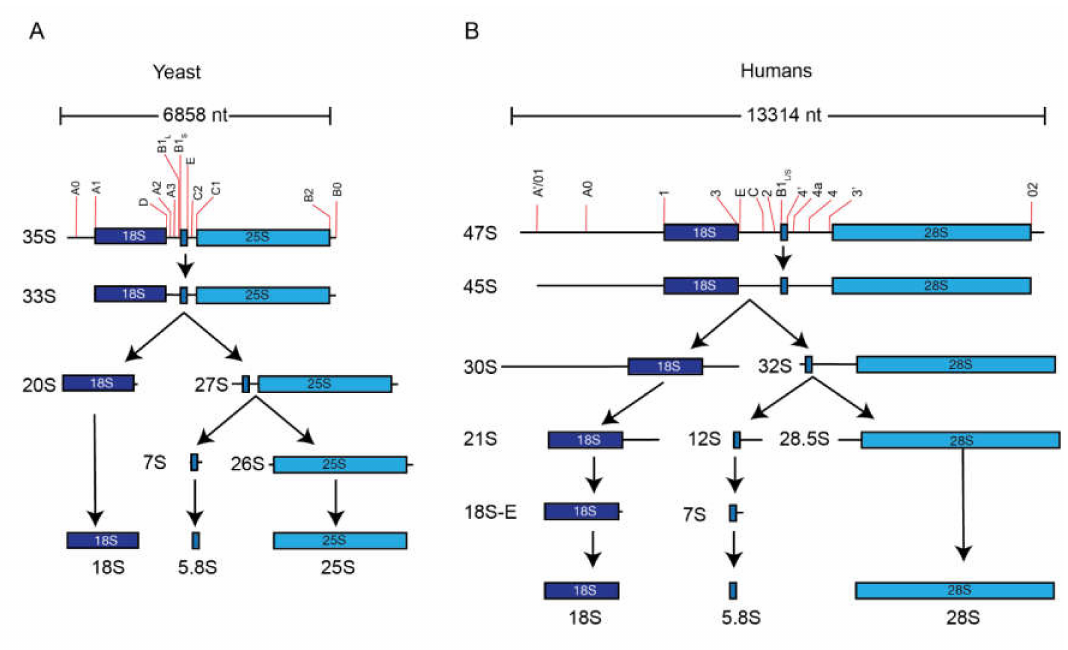
Figure 4. Simplified pathway of rRNA processing. ( A ) Yeast and ( B ) human rRNAs are generated from long polycistronic precursor molecules that must be processed to generate the mature rRNAs. This represents a simplified rRNA processing pathway in each organism, based on [94]. Note that there are minor pathways that are omitted from this